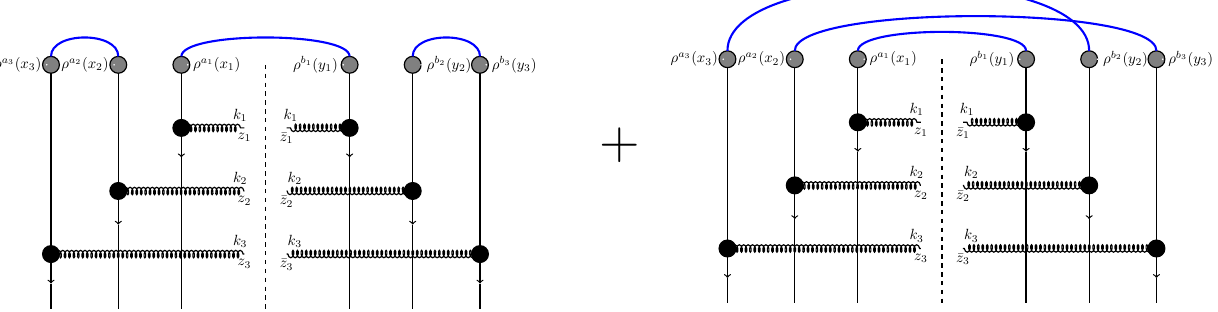
Fig. 7 Graphical illustration of the first term of the dQ-contribution to the three-gluon production cross section. It corresponds to the independent emission of gluon k 1 and interference of gluon k 2 and gluon k